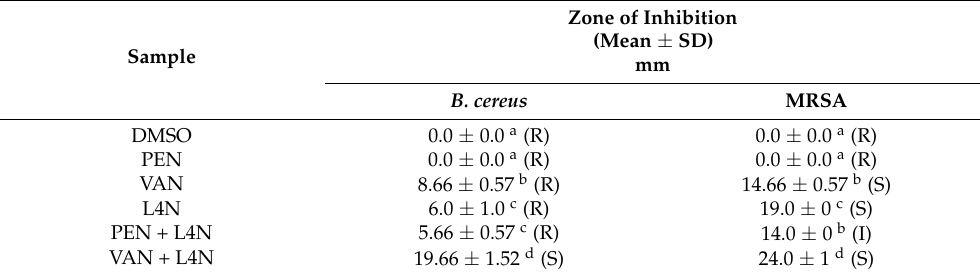
Table 2. Inhibition zones of antibiotics and luteolin 4 (cid:48) -neohesperidoside (L4N) in regard to MDR Gram-positive bacteria (MRSA and MDR B. cereus ).